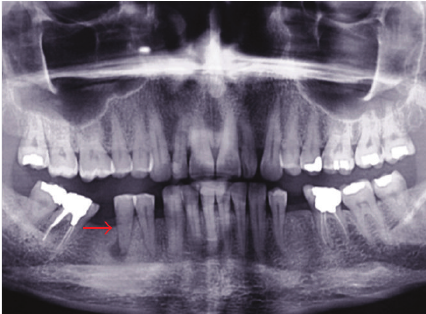
Figure 1: Preoperative radiograph; the pulp space of the right second mandibular premolar has been seriously obliterated and periapical radiolucency is observed at the apex of the tooth.